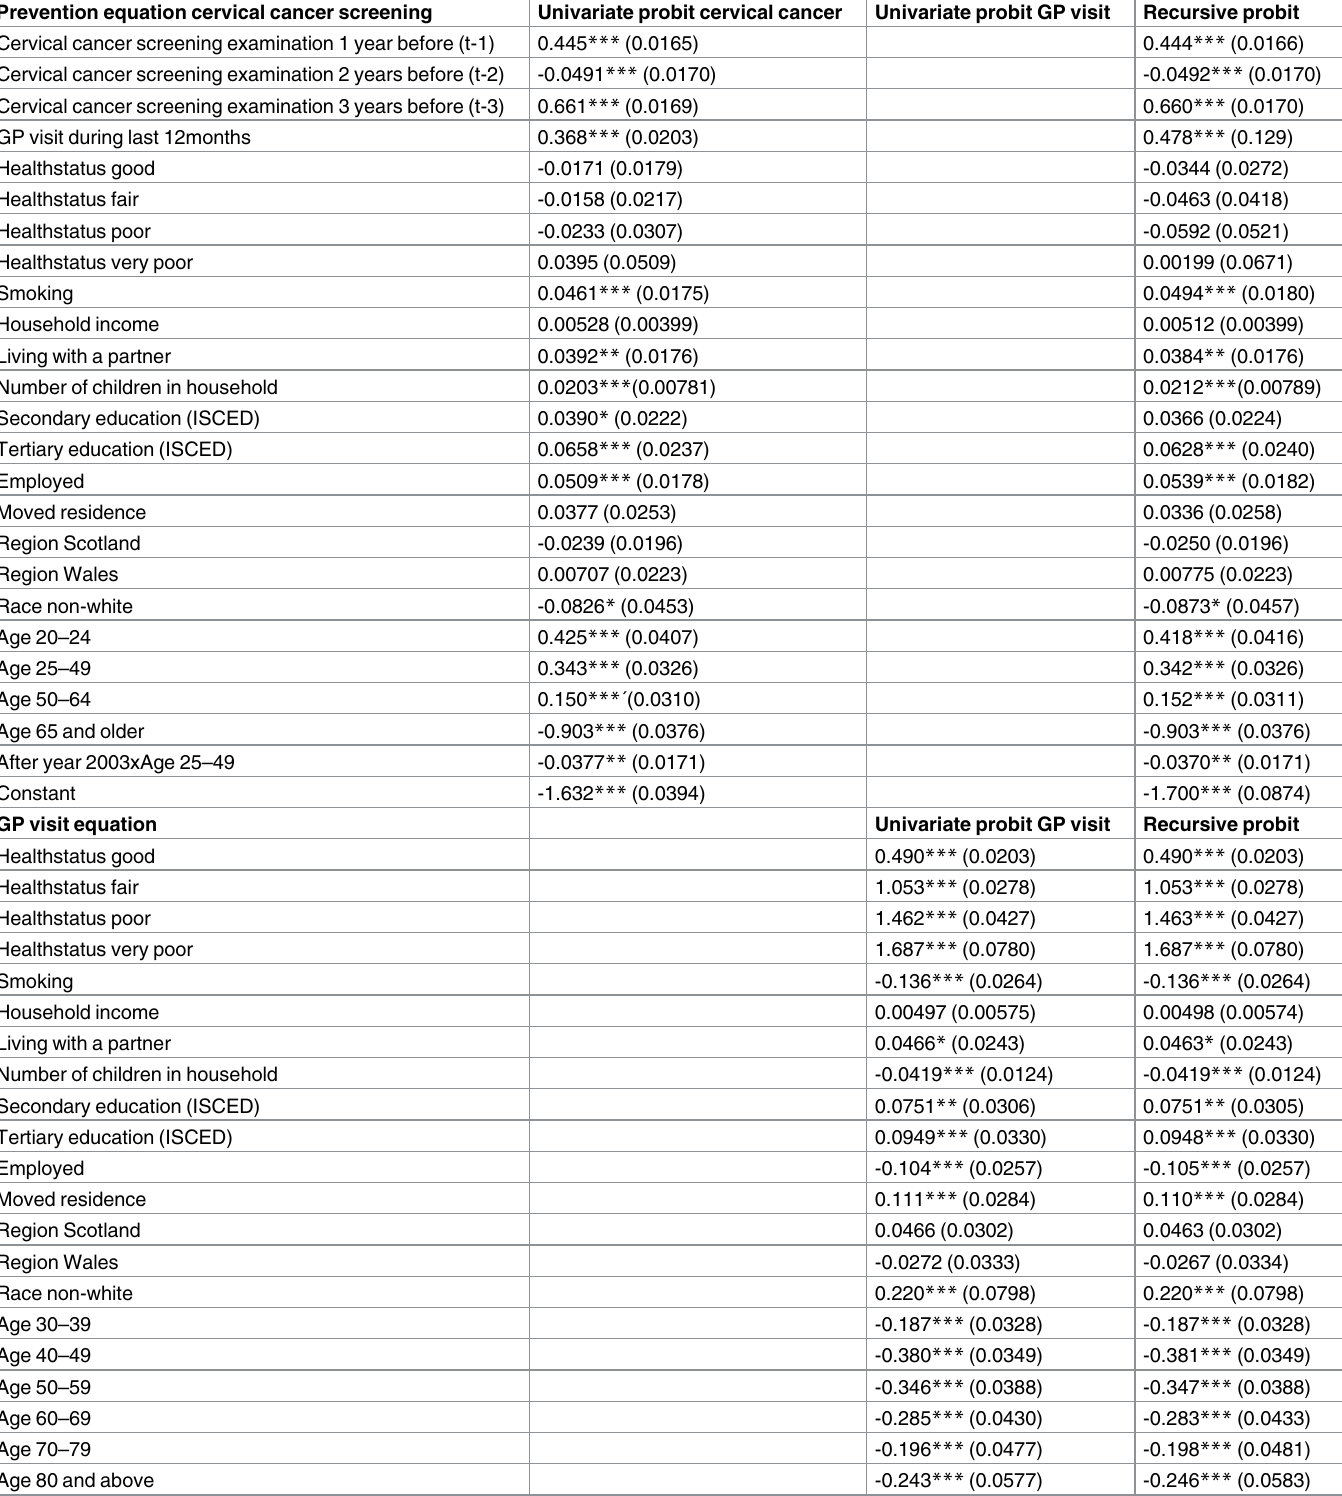
Table 3. Univariate probit and recursive probit estimatesof cervicalcancer screening and GP visits in Great